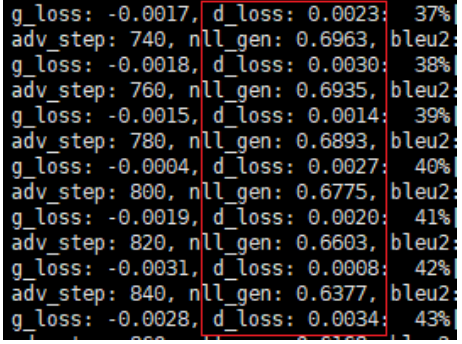
Figure 5. The discriminator loss of RelGAN.